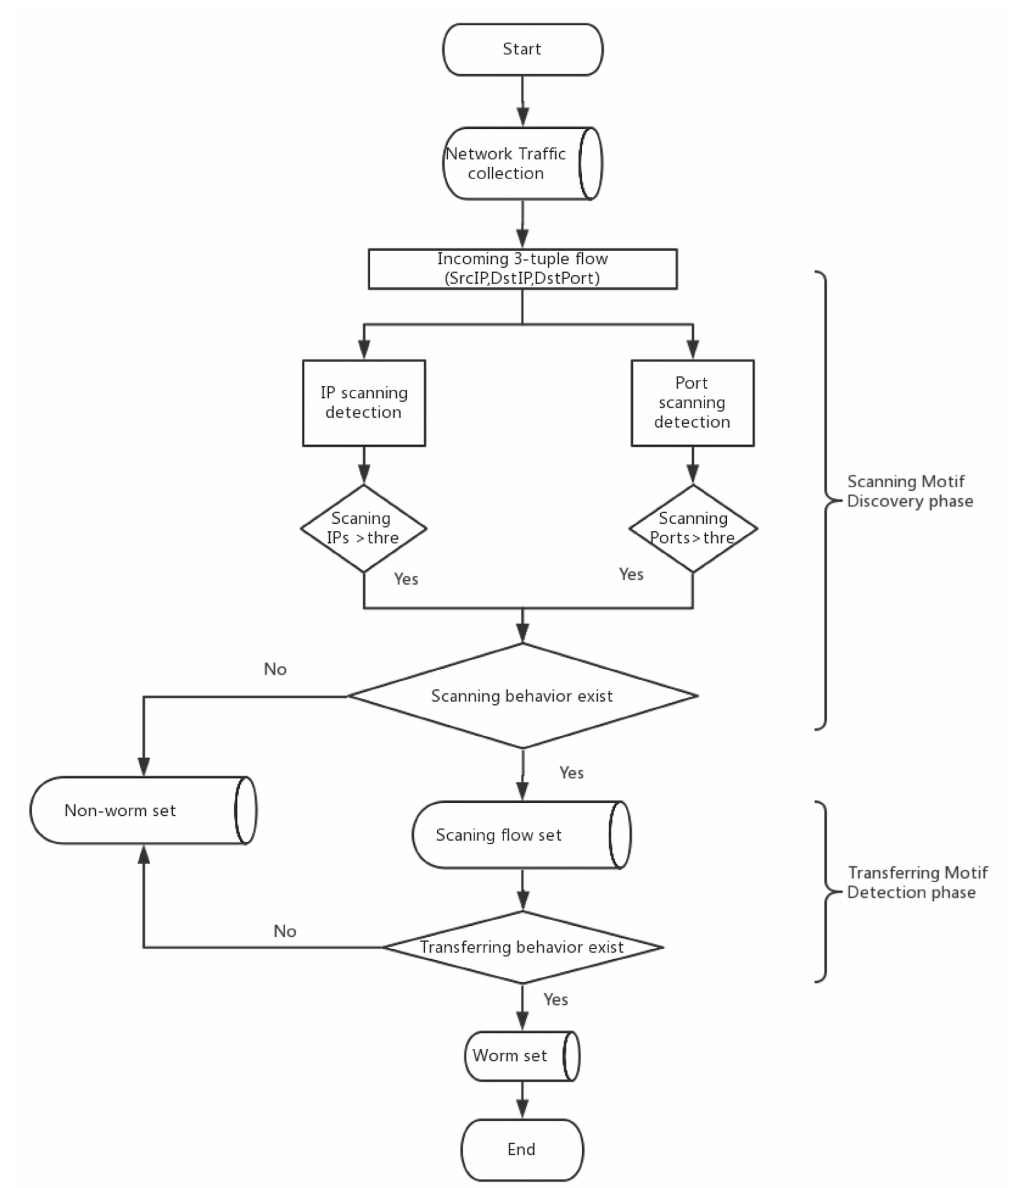
Figure 4. Flow chart of our approach